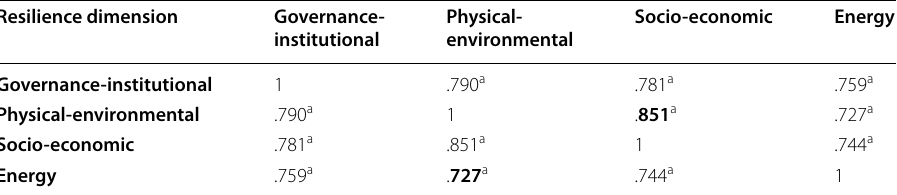
a Correlation is significant at the 0.01 level (two-tailed)